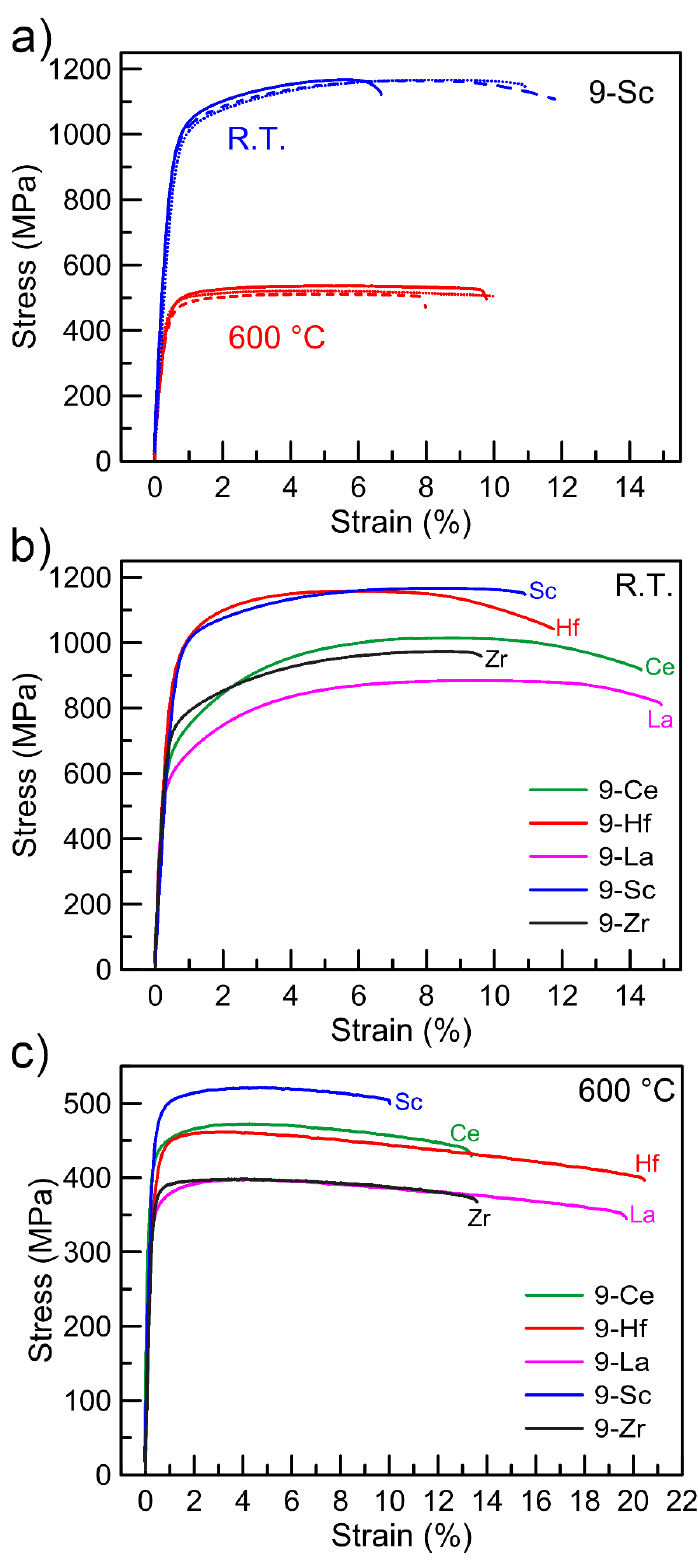
Figure 4. The overview of all tensile stress–strain curves of 9-Sc ( a ), tensile stress-strain curves of 9Cr ODS steels tested at RT ( b ), and at 600 °C ( c ).